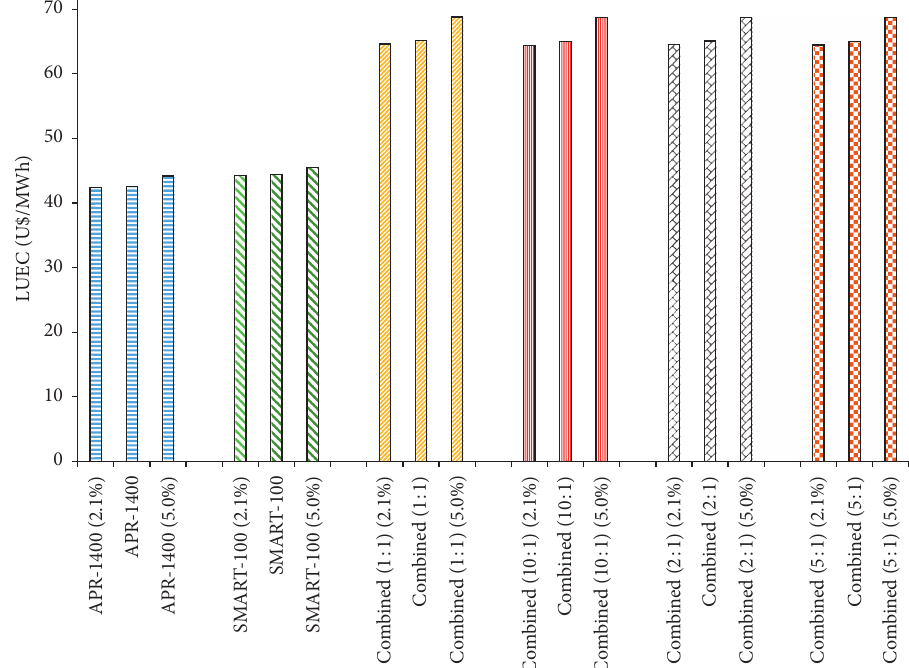
Figure 21: The effect of changing the IDC discount rate ratio of the LUECs for each reactor design (i.e., 2.1%, 2.5%, 5%) of the single reactor (APR-1400 and SMART-100) and the combined nuclear fleet (APR-1400 and SMART-100) for the different compositions of reactor designs with varying capital cost of the SMART-100 reactor. Numbers in parenthesis ( X : Y ) represent the composition of reactor designs (i.e., X units of APR-1400 and Y units of